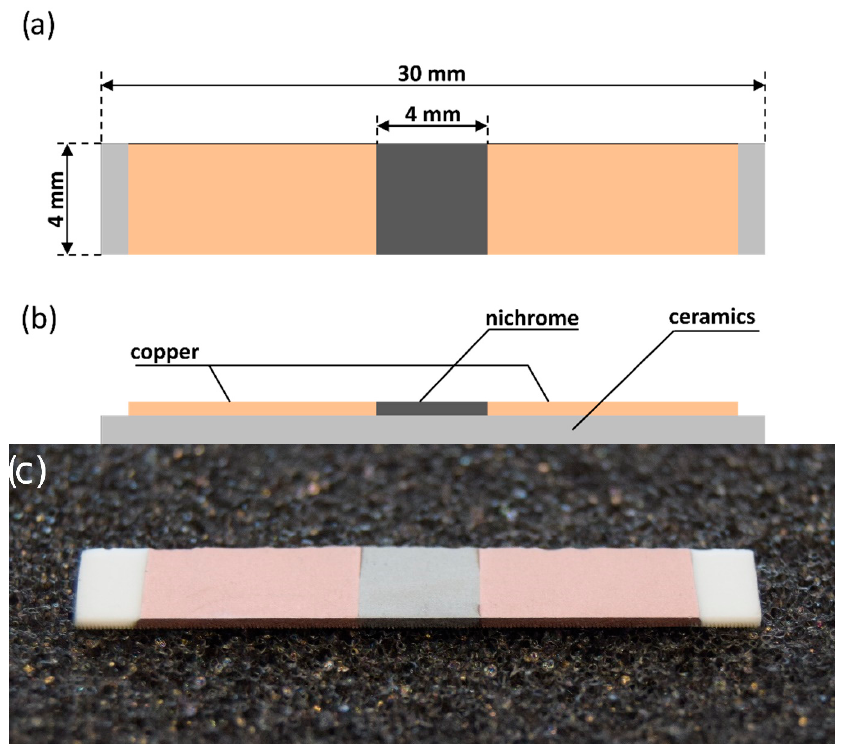
Figure 3. Diagram of a microheater: top view ( a ), cross-section ( b ), and a photo of the manufactured device ( c ).